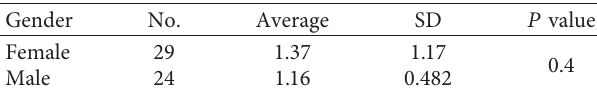
Figure 2: Frequency of patients with supernumerary teeth by type. Table 2: Comparison of the average number of supernumerary teeth by gender.